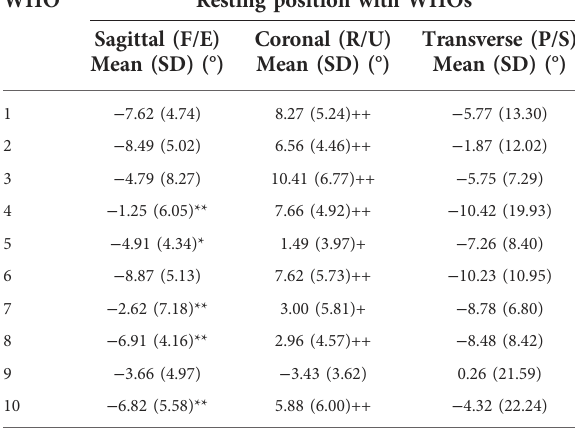
TABLE 2 Resulting mean (SD) resting position in the three planes (sagittal, coronal, and transverse) by WHOs across all ADLs. WHO Resting position with